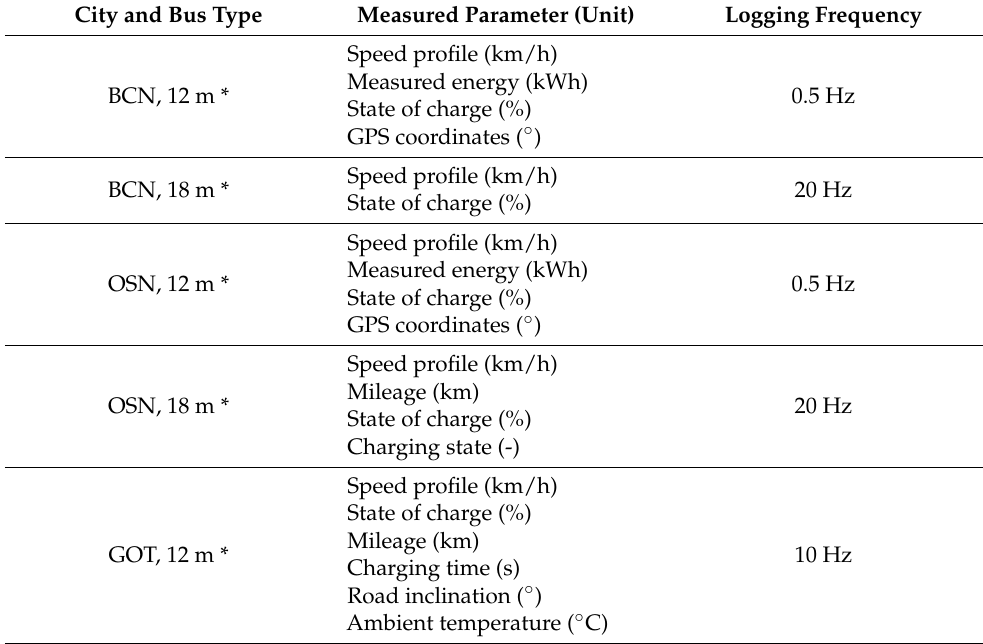
Table 1. Overview of the measured data